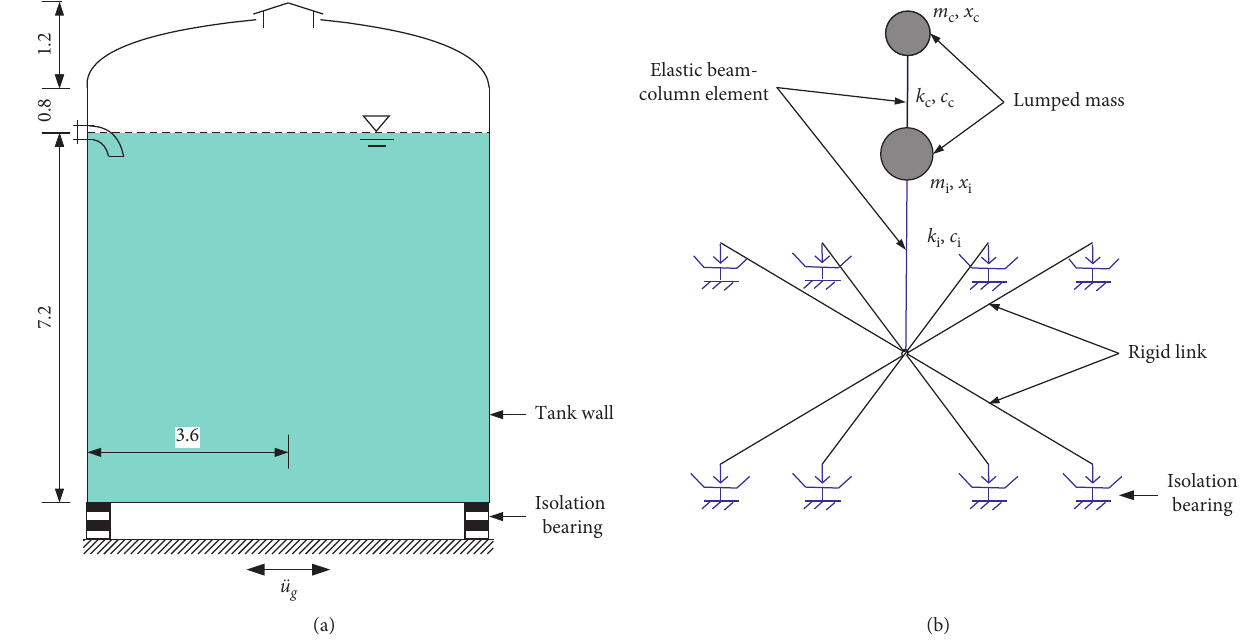
Figure 1: Base-isolated steel water storage tank: (a) physical model; (b) stick model.